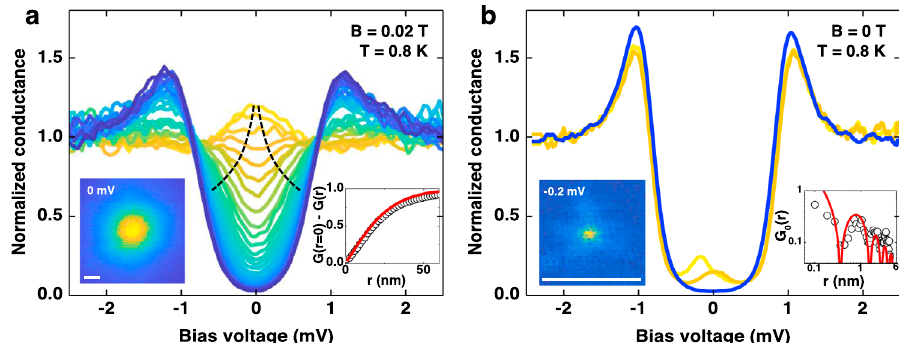
Fig. 2 Length scales of CdGM and YSR states. a Tunneling conductance from the center of a vortex (yellow to blue) in 2H-NbSe 1.8 S 0.2 . Dashed lines represent schematically the splitting of the zero bias conductance peak when leaving the vortex core, a characteristic feature of CdGM states. In the lower left inset we show a zero bias conductance map. In the lower right panel we show as white circles the radially averaged zero bias conductance G as a function of the radius. b Tunneling conductance as a function of the position at a magnetic Fe impurity (yellow and ochre curves are close to the impurity center and separated approximately by λ F ≈ 0.7 nm) and far from it (blue) in 2H-NbSe 1.8 S 0.2 . The tunneling conductance map at the bias voltage where we observe a maximum of the conductance in the yellow curve is shown in the lower left panel. In the lower right panel we show as white circles the spatial dependence of the conductance along a line from the position of the impurity outwards. Red lines in the lower right insets follows roughly the expected dependencies for the spatial variation of the LDOS for CdGM ( a ) and YSR ( b ) states, discussed in previous work 18,21 – 23 . White bars in the lower left insets of a , b are both 10 nm long.